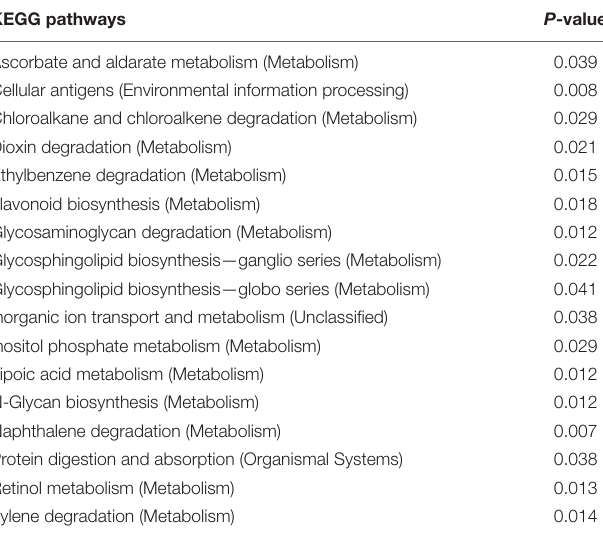
TABLE 2 | KEGG pathways with significantly varied enrichment in the cecal microbiota of adult male Brandt’s vole in response to the administration of 6-MBOA ( n = 6).